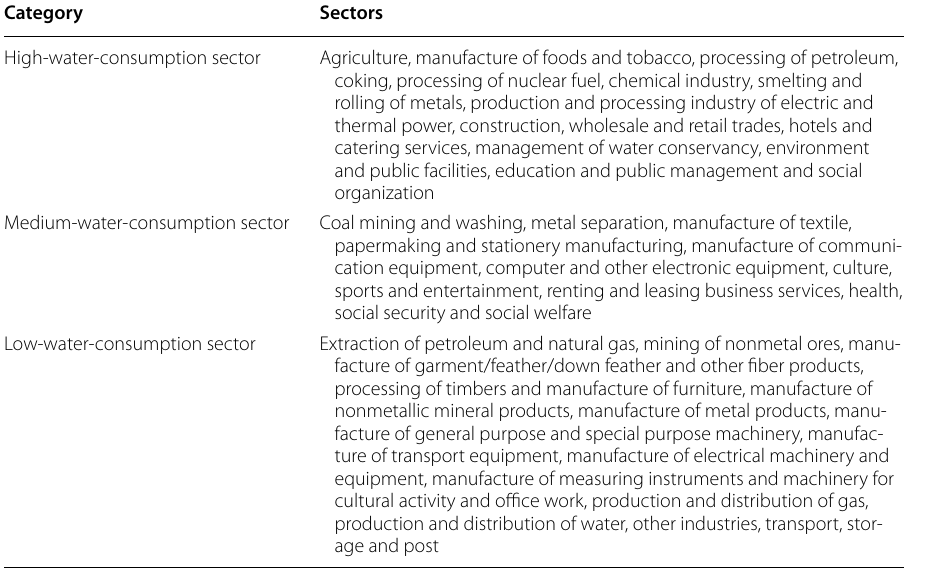
Table 1 Categorization of water consumption sector (take 2013 as the example) Category